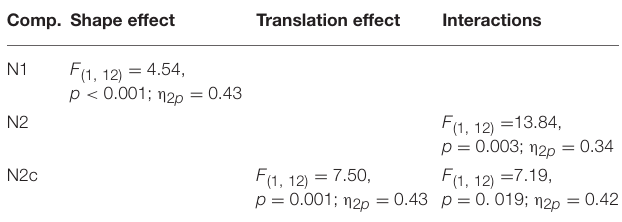
TABLE 2 | Main effects and interactions.